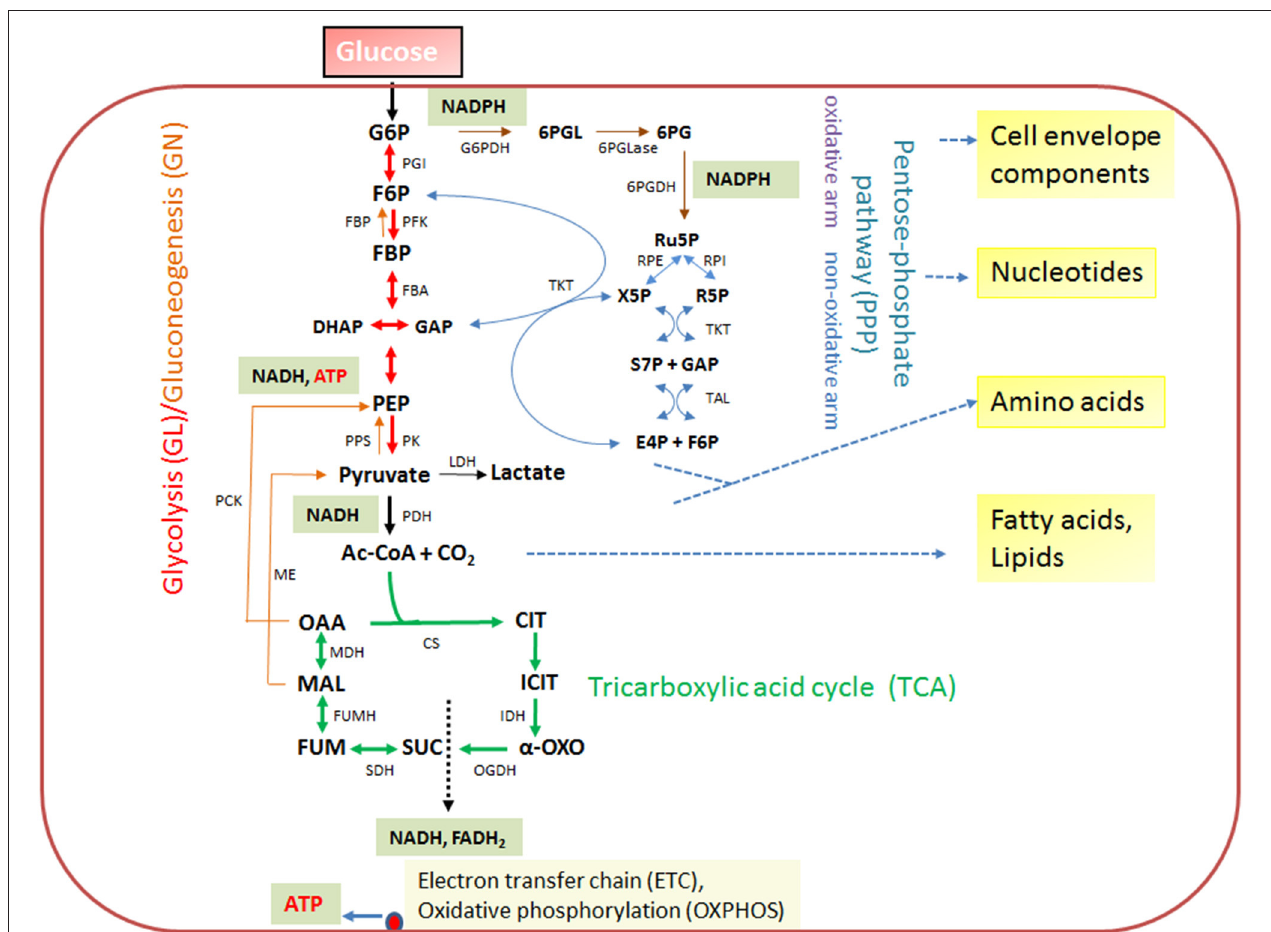
FIGURE 2 | Schematic presentation of the basic catabolic and anabolic processes of a typical heterotrophic prokaryotic cell: glycolytic pathway (GL), pentose-phosphate pathway (PPP) with its oxidative and non-oxidative arms, and tricarboxylic acid cycle (TCA). The specific reactions essential for gluconeogenesis (GN) (in addition to the reversible GL reactions) are catalyzed by PEP carboxykinase (PCK), PEP synthetase (PPS) and fructose-1,6-diphosphatase (FBPase). The anaplerotic reactions are not shown with the exception of the reaction leading from malate to pyruvate, catalyzed by the malic enzyme (ME) which may play an important role the intracellular metabolism of IBPs (see Figure 3 ). The ATP production by oxidative phosphorylation (OXPHOS) via the electron transfer chain (ETC) is also indicated. Metabolites of GL: G6P, glucose-6P; F6P, fructose-6P; FBP, fructose-1,6 diphosphate; DHAP, dihydroxyacetone phosphate; GAP, glyceraldehyde-3P; PEP, phosphoenolpyruvate. Metabolites of the PPP: 6PGL, 6-phosphogluconolactone; 6PG, 6-phosphogluconate; Ru5P, ribulose-5P; X5P, xylulose-5P; R5P, ribose-5P; S7P, sedoheptulose-7P; E4P, erythrose-4P. Metabolites of the tricarboxylic acid cycle (TCA): OAA, oxaloacetate; CIT, citrate; ICIT, isocitrate; α -OXO, alpha-oxoglutarate; SUC, succinate, FUM, fumarate, MAL, malate. Enzymes of the GL: PGI, phosphoglucoisomerase; PFK, phosphofructokinase; FBA, fructobisphosphate aldolase; PK, pyruvatekinase. PDH, pyuvate dehydrogenase. LDH, lactate dehydrogenase. Enzymes of the PPP: G6PDH,